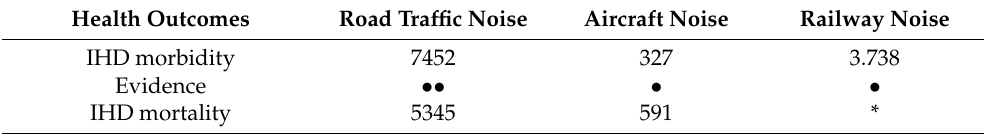
Table 9. Sum of the DALYs attributable to traffic noise by evidence